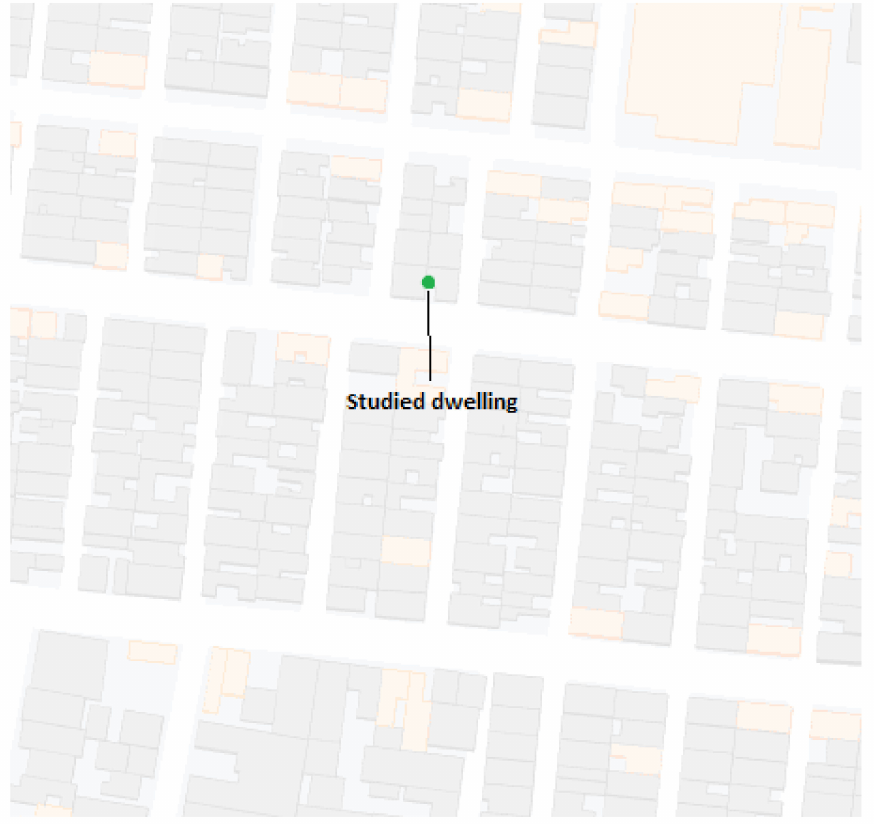
Figure 5. Urban location of the simulated dwelling (green dot)